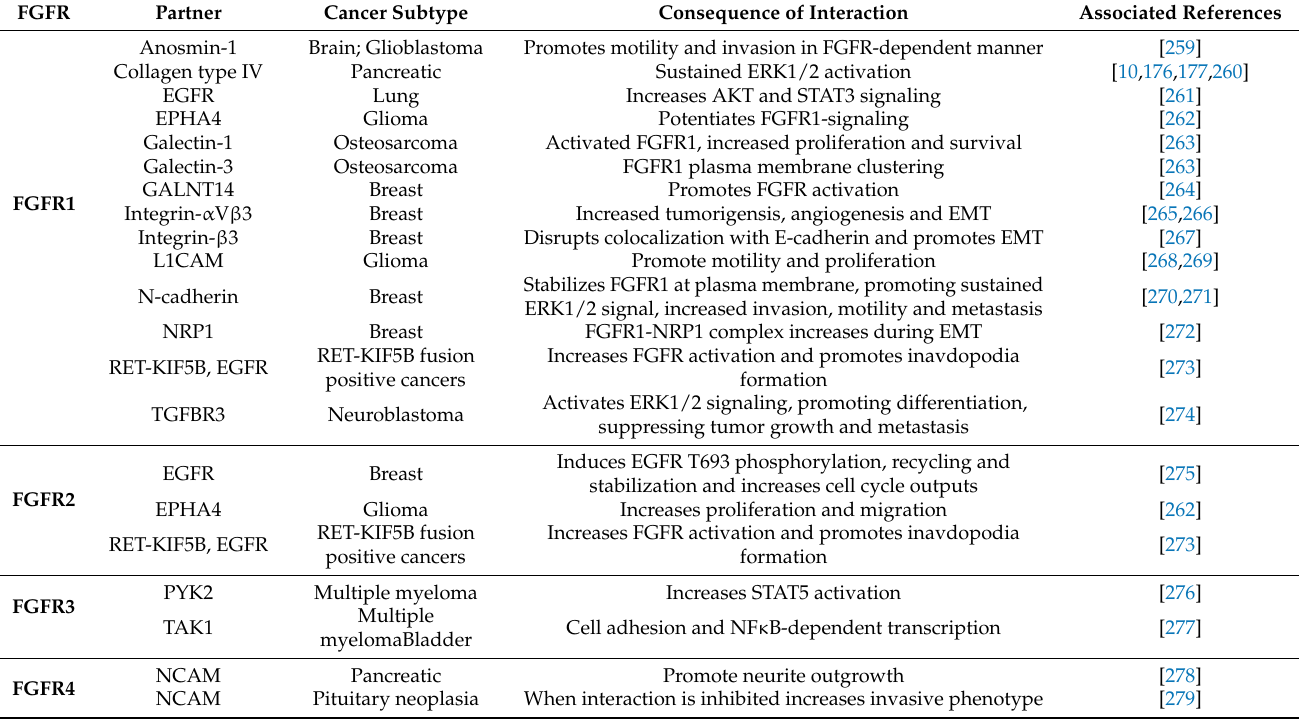
Table 3. A summary of noncanonical interaction partners of FGFR1-4 which have been linked to cancer. FGFR Partner Cancer